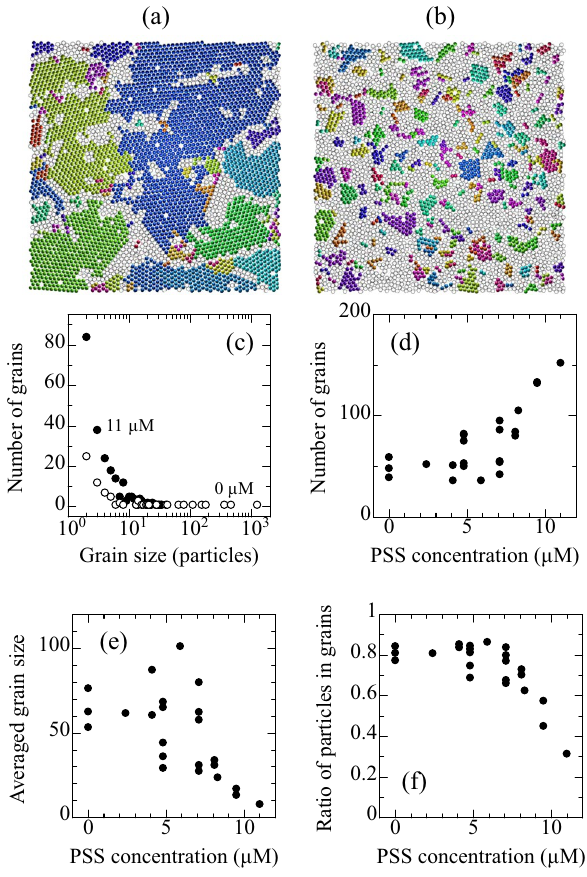
Figure 3. Reconstructed images of the first layer at ( a ) 0.0 and ( b ) 11 µ M. Each grain is colored with a different color. Particles considered to belong to disordered regions are colored with white. Image size is 98 µ m ( c ) Histogram of the grain size at 0.0 (open circle) and 11 µ M (solid circle). ( d ) The number of grains, ( e ) the averaged grain size, and ( f ) the ratio of particles in grains to the total particles. ( d )–( f ) were analyzed for grains consisting of three or more particles in the first